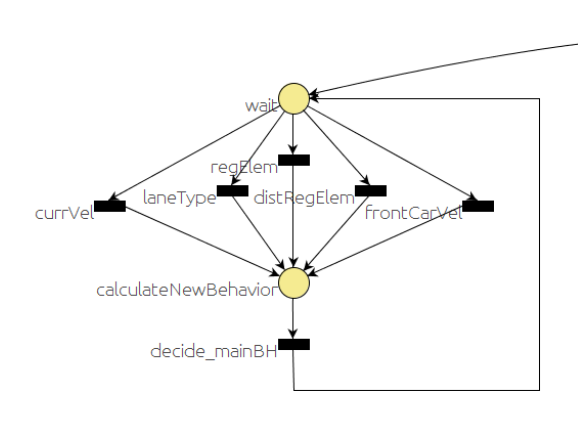
Figure 4. Selector PN: behavior decision part.